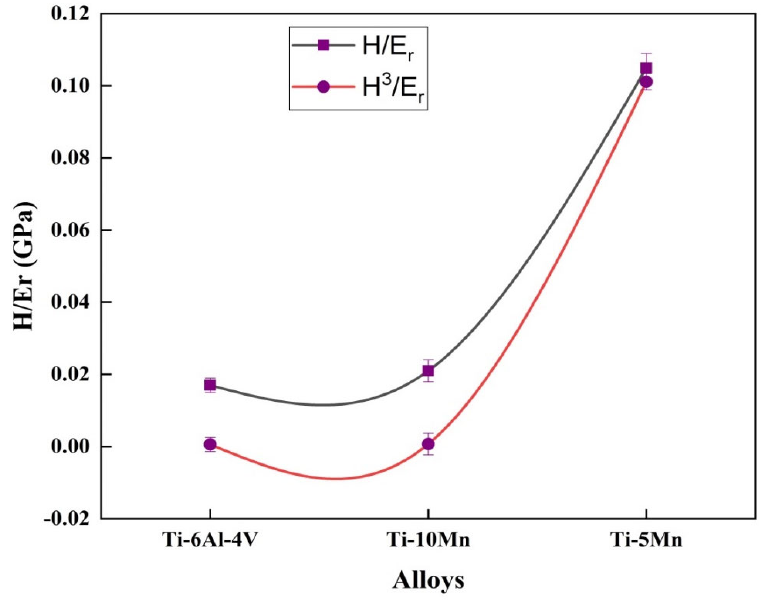
Figure 7. The yield pressure and wear properties of the titanium ‐ based